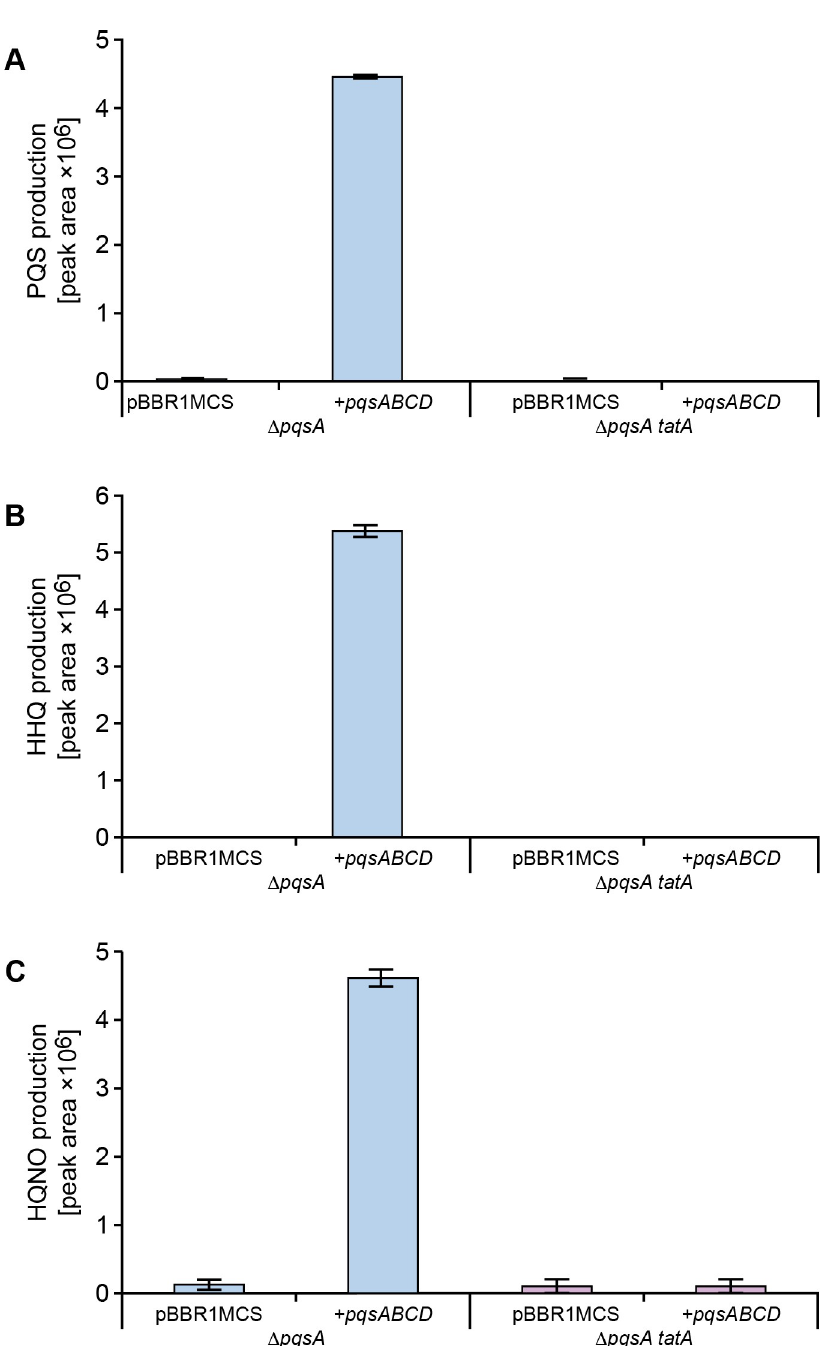
Fig 8. AQ biosynthesis is not restored in a tatA Δ pqsA double mutant by plasmid-borne pqsABCD in the absence of autoinduction. Semi-quantitative analysis by LC-MS/MS of PQS, HHQ and HQNO production by P . aeruginosa pqsA and tatA Δ pqsA mutants respectively without or with the pqsABCD biosynthetic genes provided in trans via pBBR1MCS-5:: pqsABCD . Experiments were repeated in triplicate at least twice.